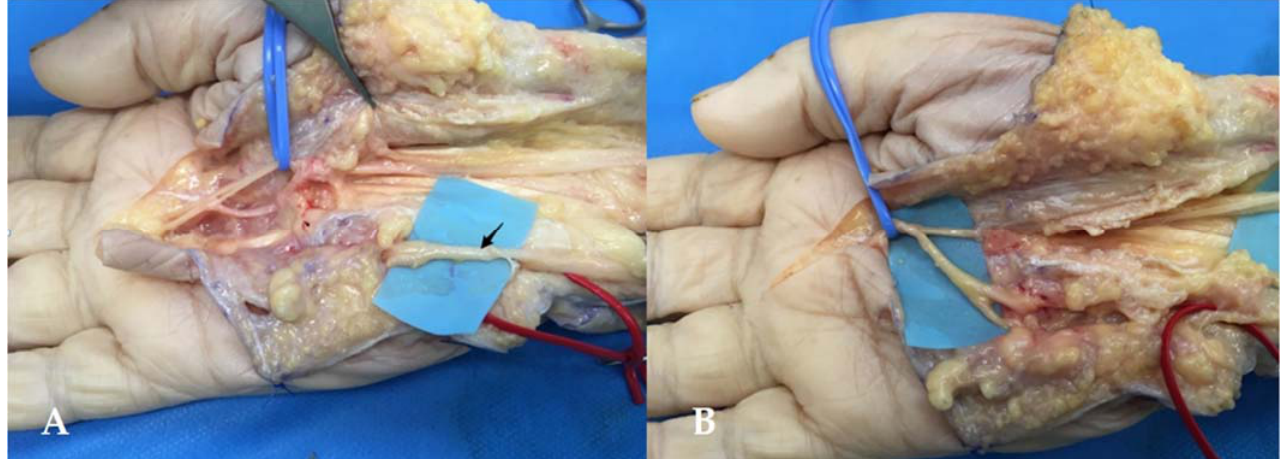
Figure 7. ( A ) Third common palmar digital branch of the median nerve. The third common palmar digital nerve was isolated in the blue loop. The SBUN is shown by the black arrow. ( B ) End-to-side (ETS) suture. The distal stump of the SBUN was transected in proximal and twisted 180° before the ETS suture with the third common palmar digital nerve.